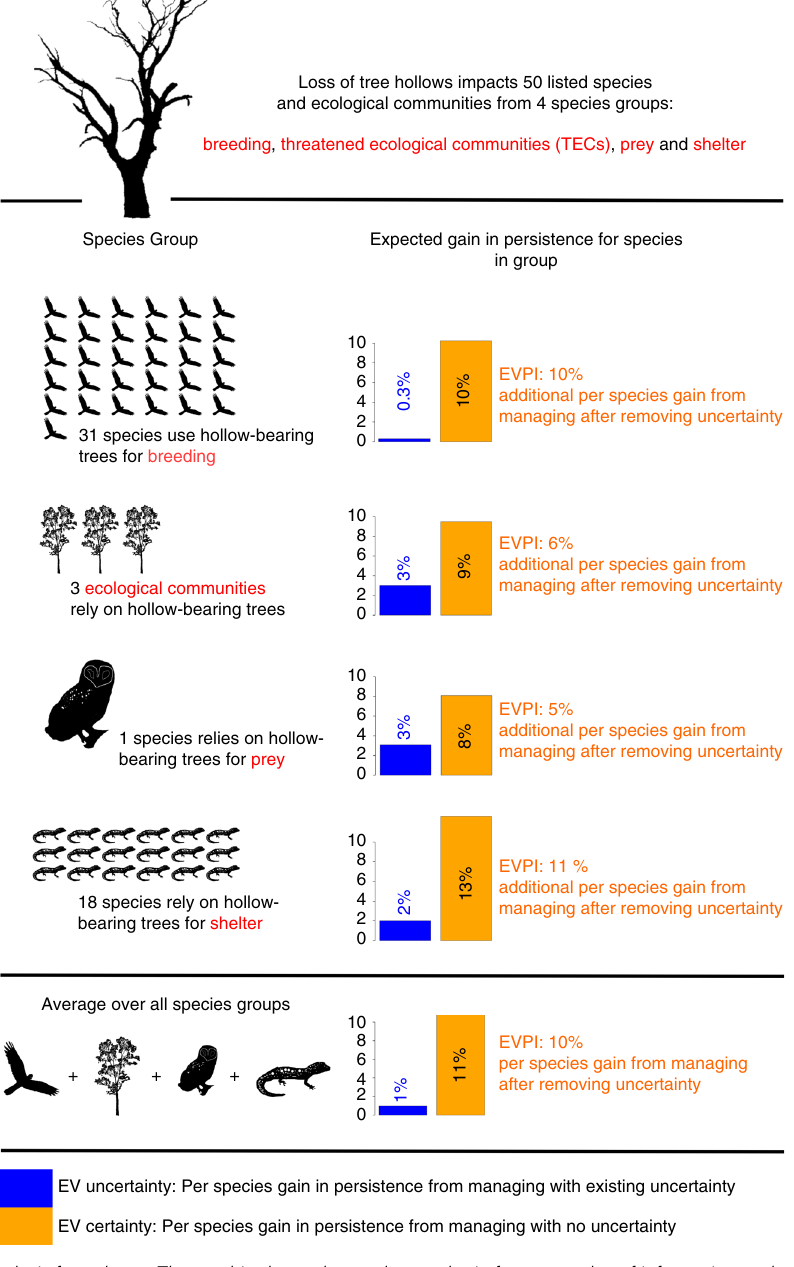
implementing best management practice using current knowl- edge may be a good strategy.